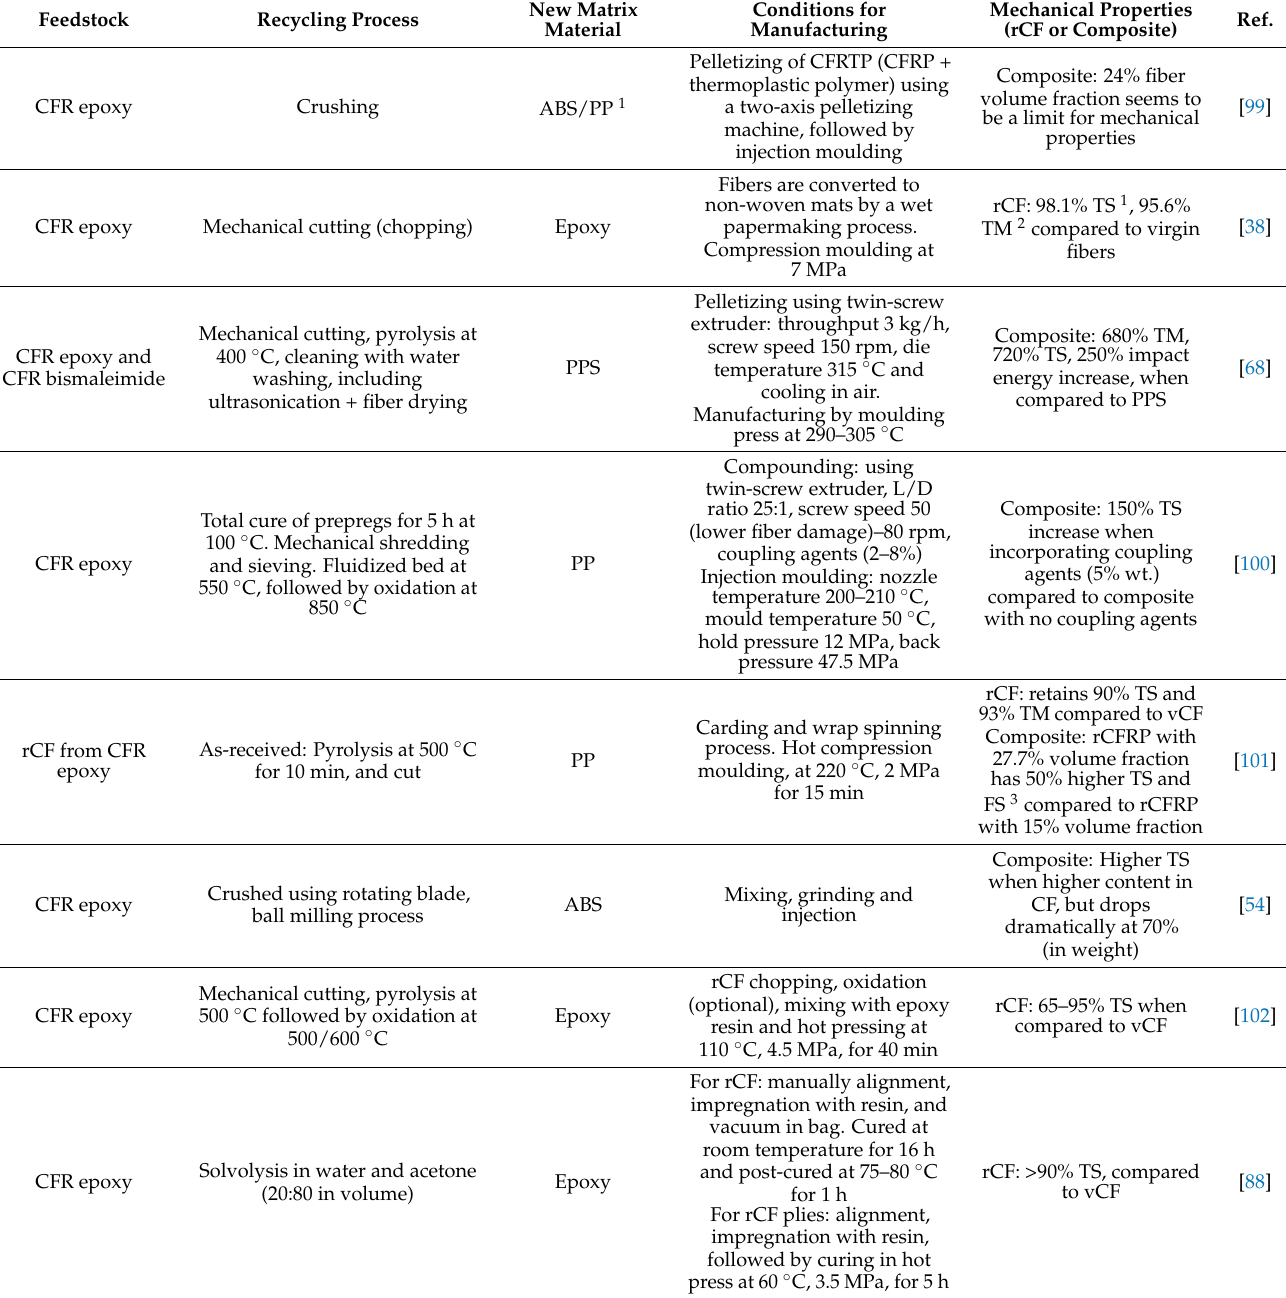
Table 4. General characteristics, manufacturing conditions, and mechanical properties in the reuse of recycled CF and CFRP.